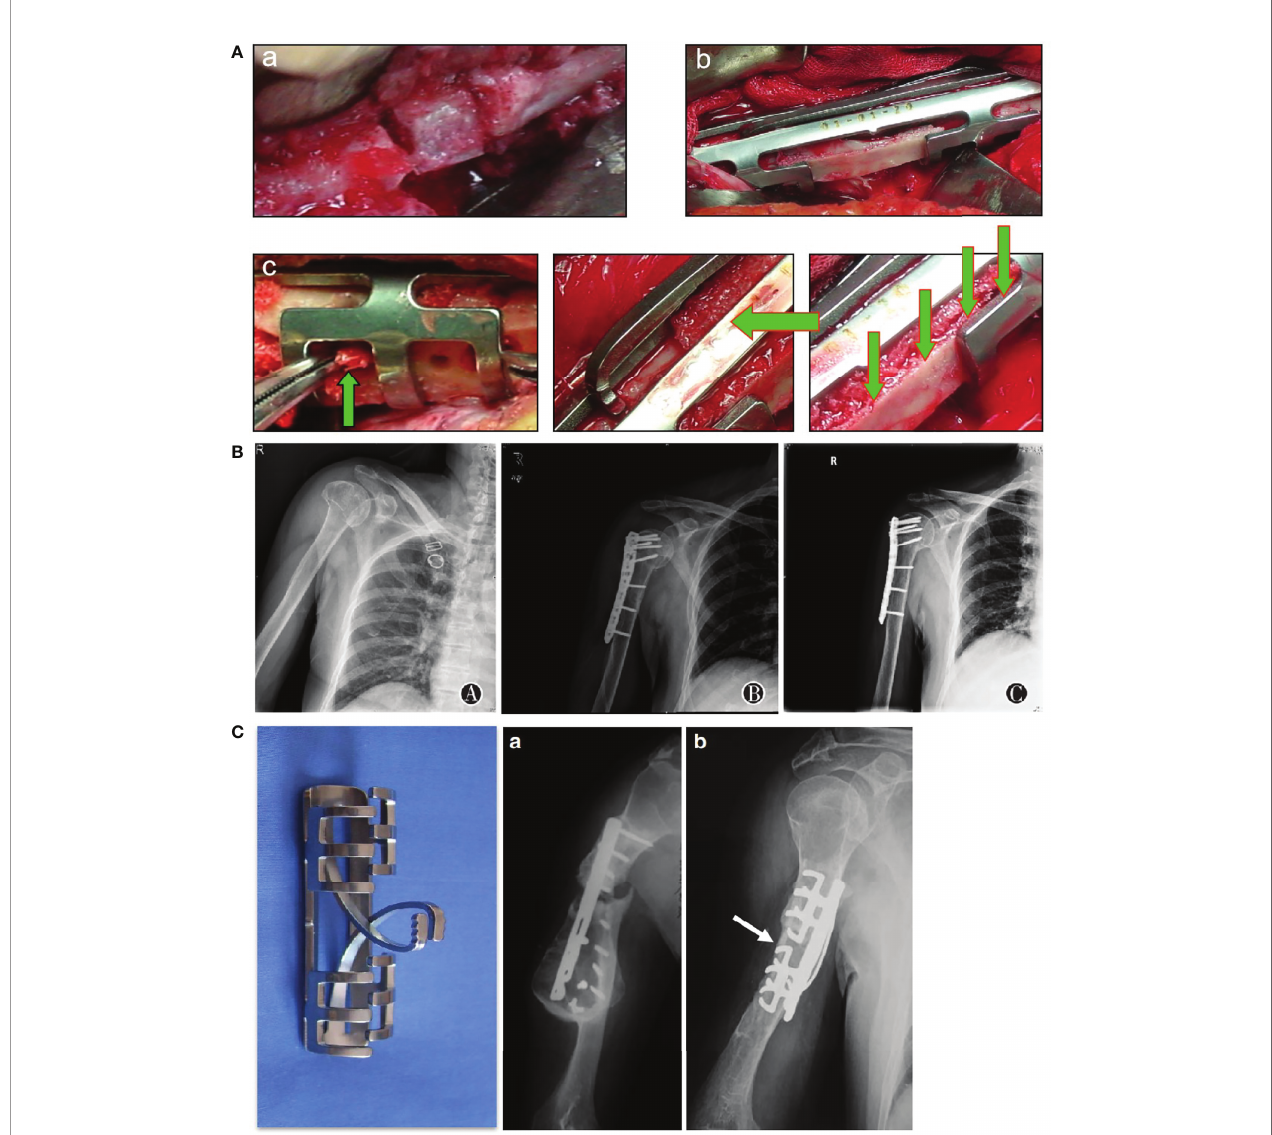
FIGURE 3 | Emphasize proper internal fi xation and bone implantation. (A) Improvement in bone grafting method. a cushion method; b splint method; c seeding method (45). (B) A 74-year-old patient with proximal humerus fractures treated with open reduction and internal fi xation with allograft bone graftings. a preoperative image; b immediate postoperative image; c 12 months after surgery (46). (C) a. A 55-year-old male patient with humeral shaft fracture, nonunion occurred 6 months after internal fi xation using a dynamic compression plate due to screw breakage; (b) Four months after implantation of shape memory Ni-Ti alloy swan-like bone connector fi xation and autologous bone grafting